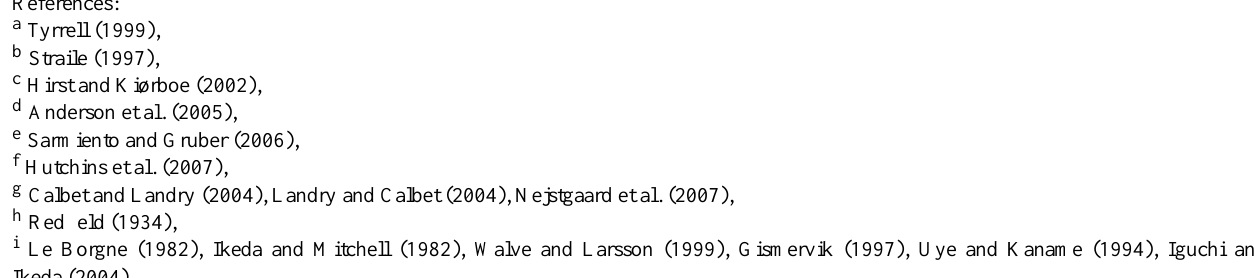
Accumulation efficiency of P when zooplankton feed on N 2 -fixers Accumulation efficiency of N when zooplankton feed on N 2 -fixers Accumulation efficiency of P when zooplankton feed on non-fixers Accumulation efficiency of N when zooplankton feed on